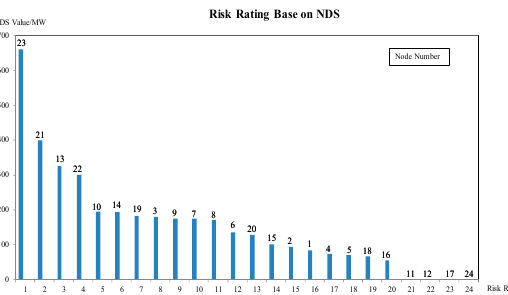
Figure 4. Diagram of risk rating based on the node disconnection severity (NDS) in the RTS-79 system.